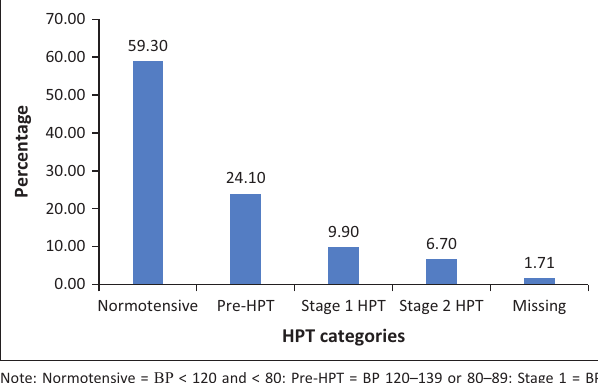
FIGURE 2: Hypertension categories of 350 patients at baseline.